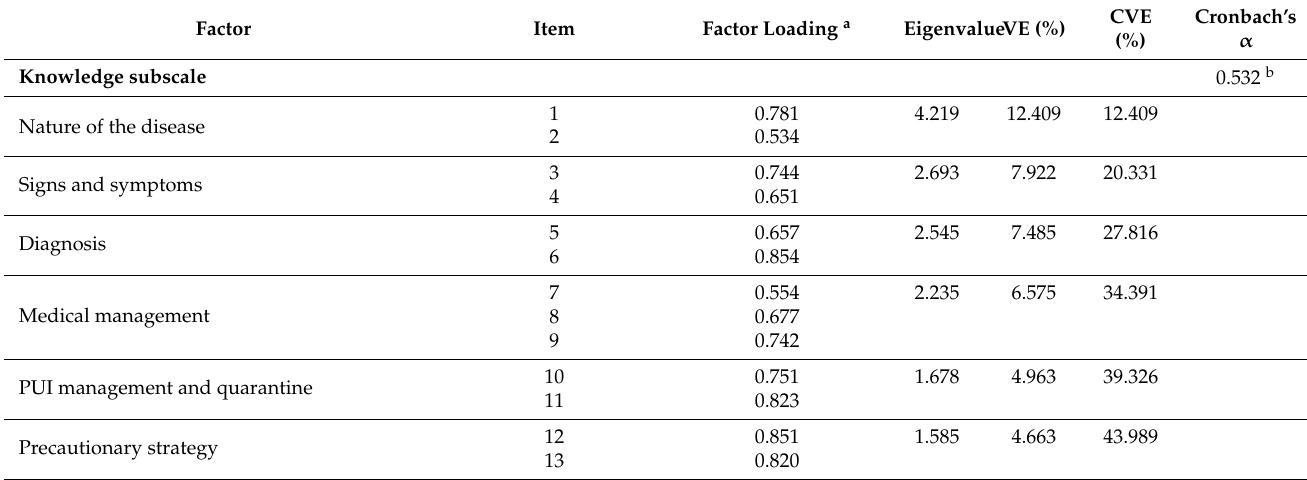
Table 3. Results of the exploratory factor